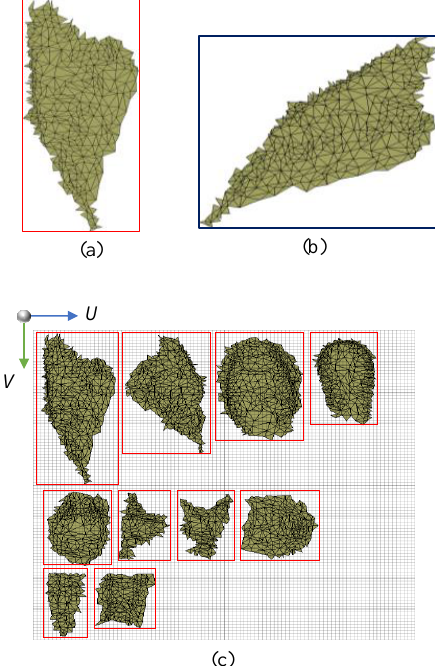
Figure 4. Mesh-islands packing: ( a ) the oriented boundary box (OBB) method to determine the boundary box, ( b ) the axis aligned bounding box (AABB) method to determine the boundary box, and ( c ) packing of all